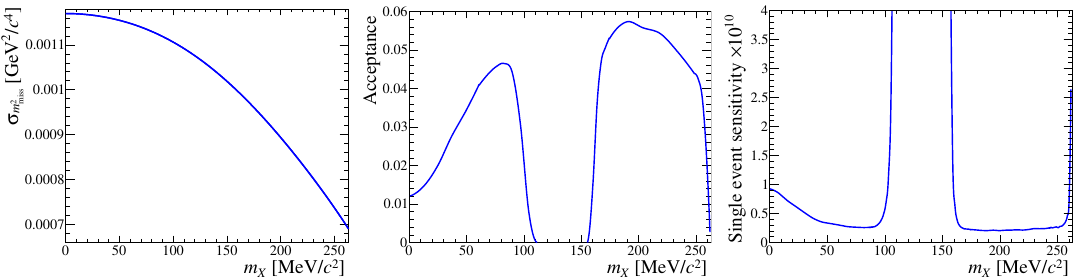
Figure 2 . Resolution of the m 2 observable (left), acceptance (centre) and single event sensitivity, miss BR SES , (right) for K + → π + X , as functions of mass hypothesis m X